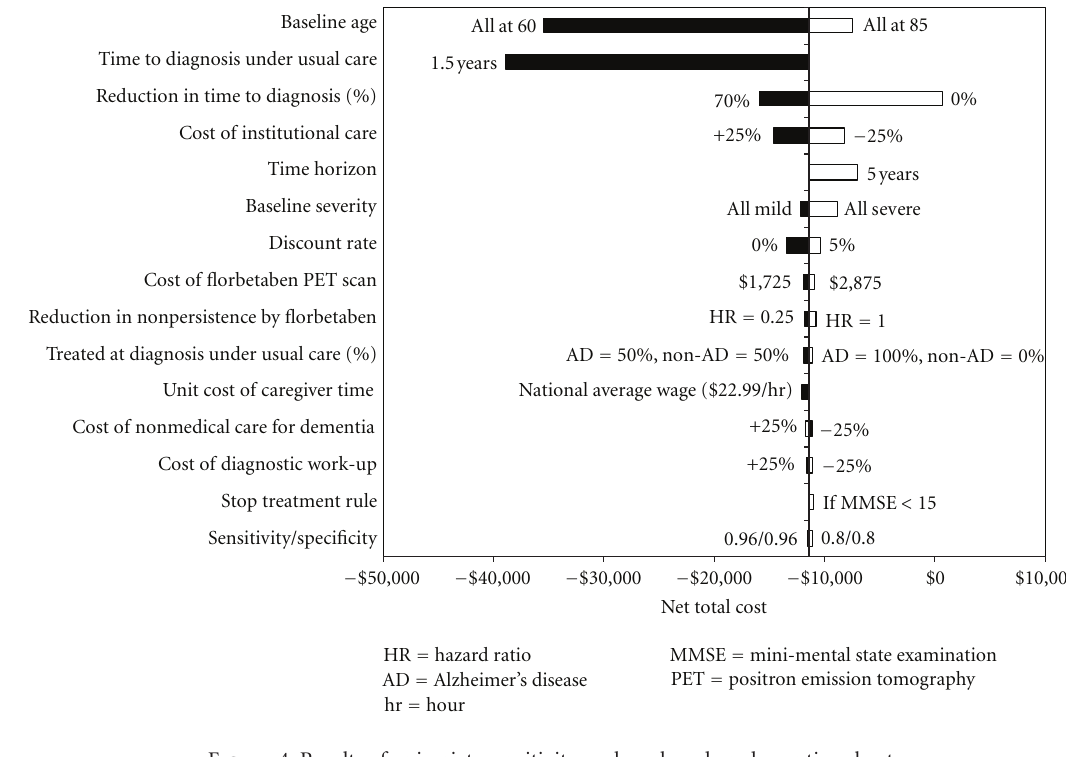
Figure 4: Results of univariate sensitivity analyses based on dementia cohort.